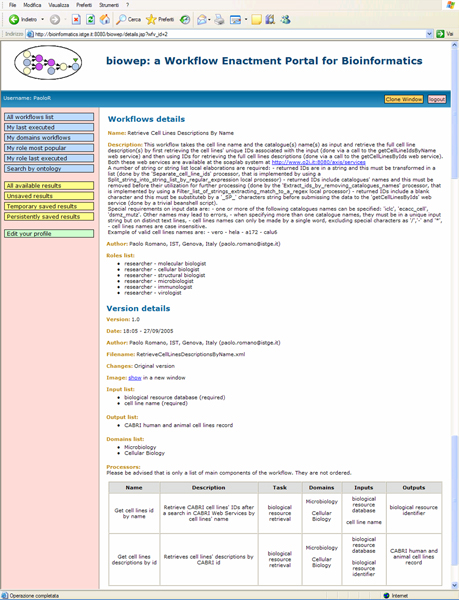
Details on a workflow included in the repository. In this figure, the web page including the detailed description of a workflow is shown. This description includes information both at the workflow and at the version levels. The first level has data such as the author and the run contexts, while the second level includes, among other information, the annotation of the workflow. A link to the diagram of the workflow is also available.